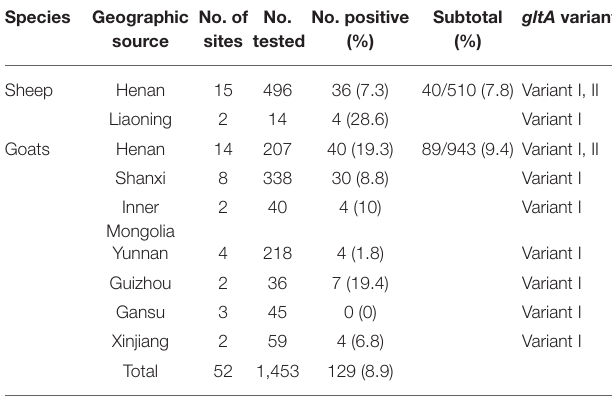
TABLE 2 | Prevalence distribution of A. capra isolates from sheep and goats from different provinces, China 2012–2017. Species Geographic